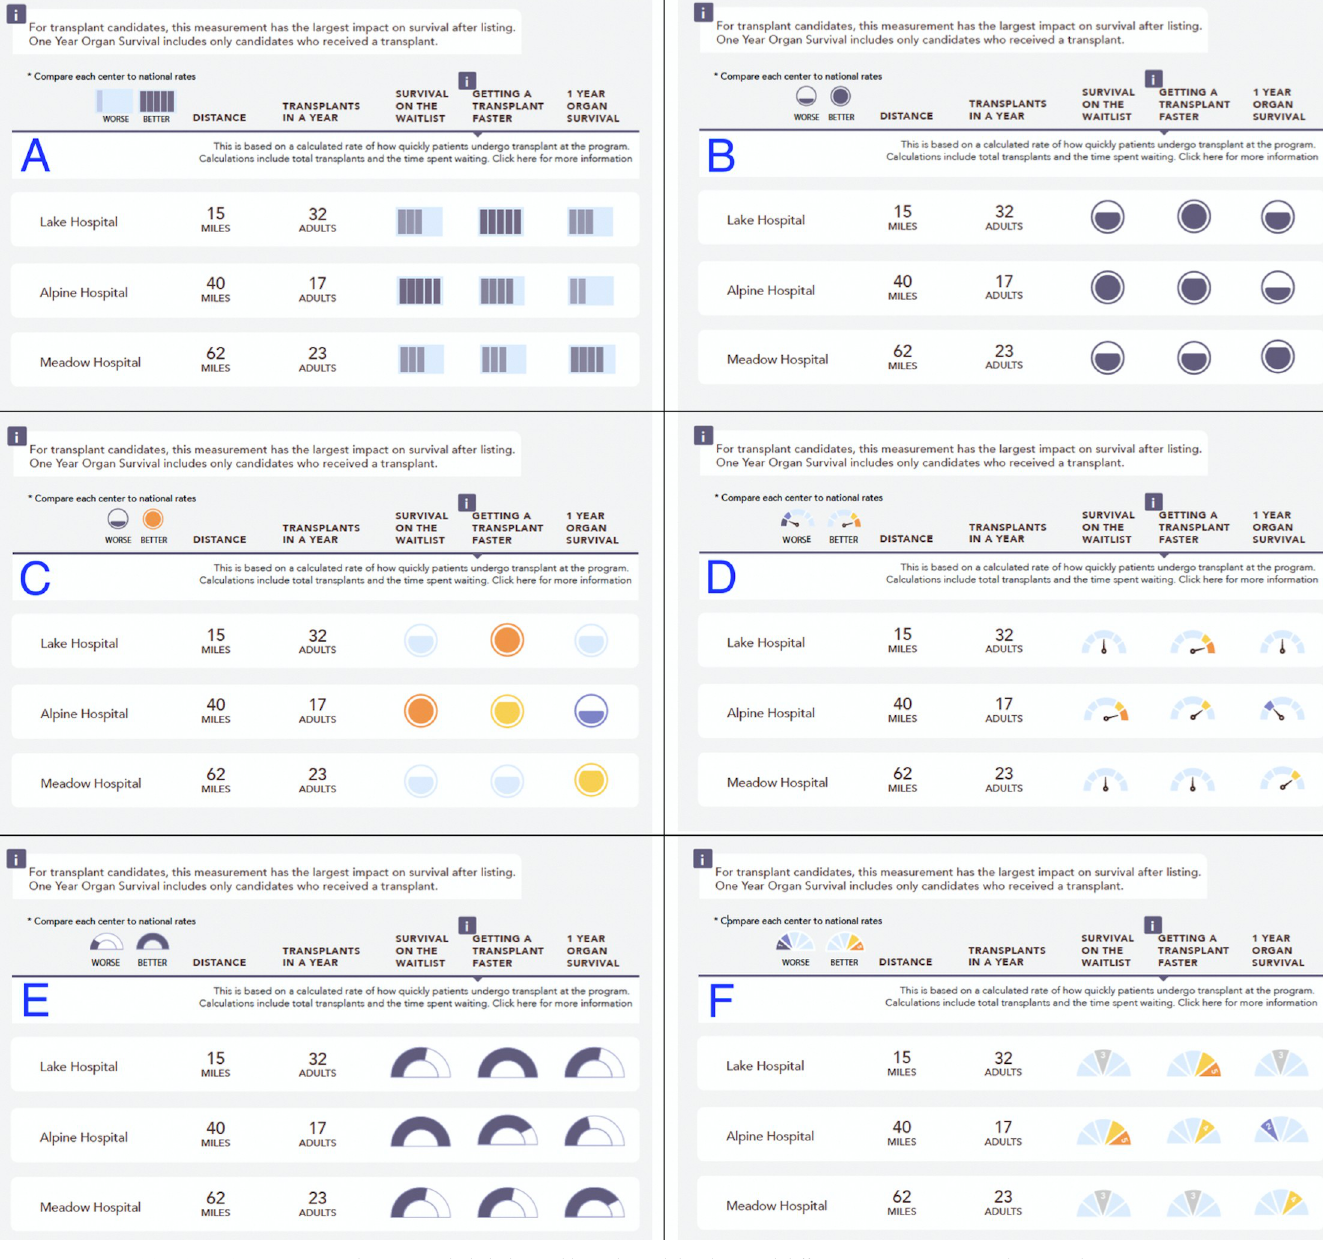
Fig 1. Images used for the online survey. Each image included identical hypothetical data but used different icons to represent the same data.